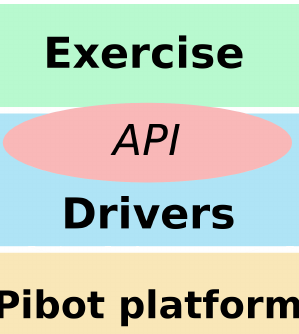
Figure 3. Architecture of the PiBot tool: hardware (platform) and software (drivers and